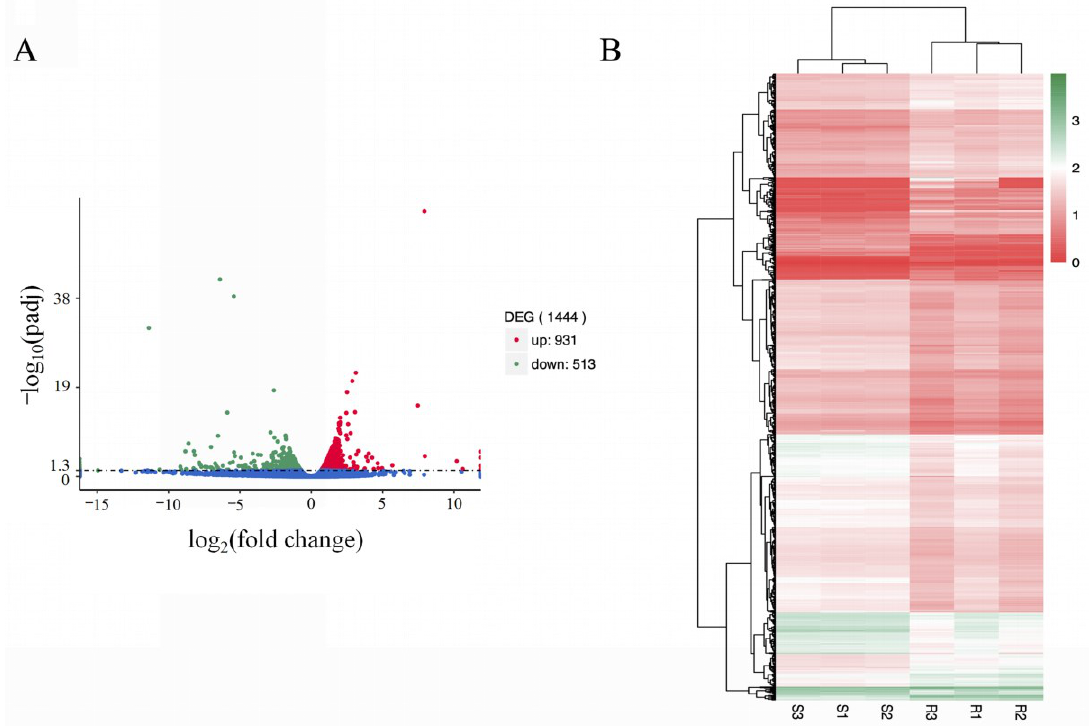
Figure 7. The differentially expressed genes (DEG) between CSBV Bces-Po19-sensitive and -resistant Japanese flounder ( Paralichthys olivaceus ). ( A ) Volcano map of DEGs. Each dot represents one gene, red dots represent the significantly up-regulated genes, and green dots represent the significantly down-regulated genes. Blue dots represent genes that are not significantly differentially expressed. ( B ) Heatmap analysis of the hierarchical clustering of DEGs. Different colors indicate differences in the expression